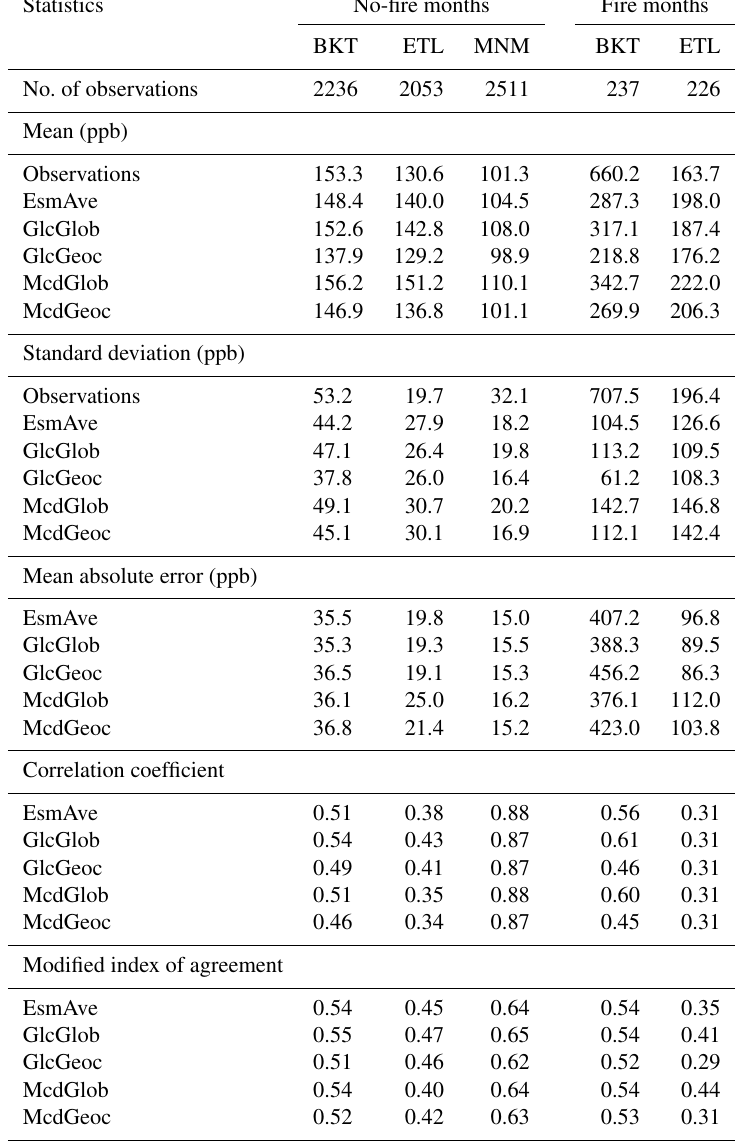
Table 5. Statistics comparing observed and simulated time series of daily atmospheric CO concentrations at the BKT, ETL, and MNM sites between 2009 and